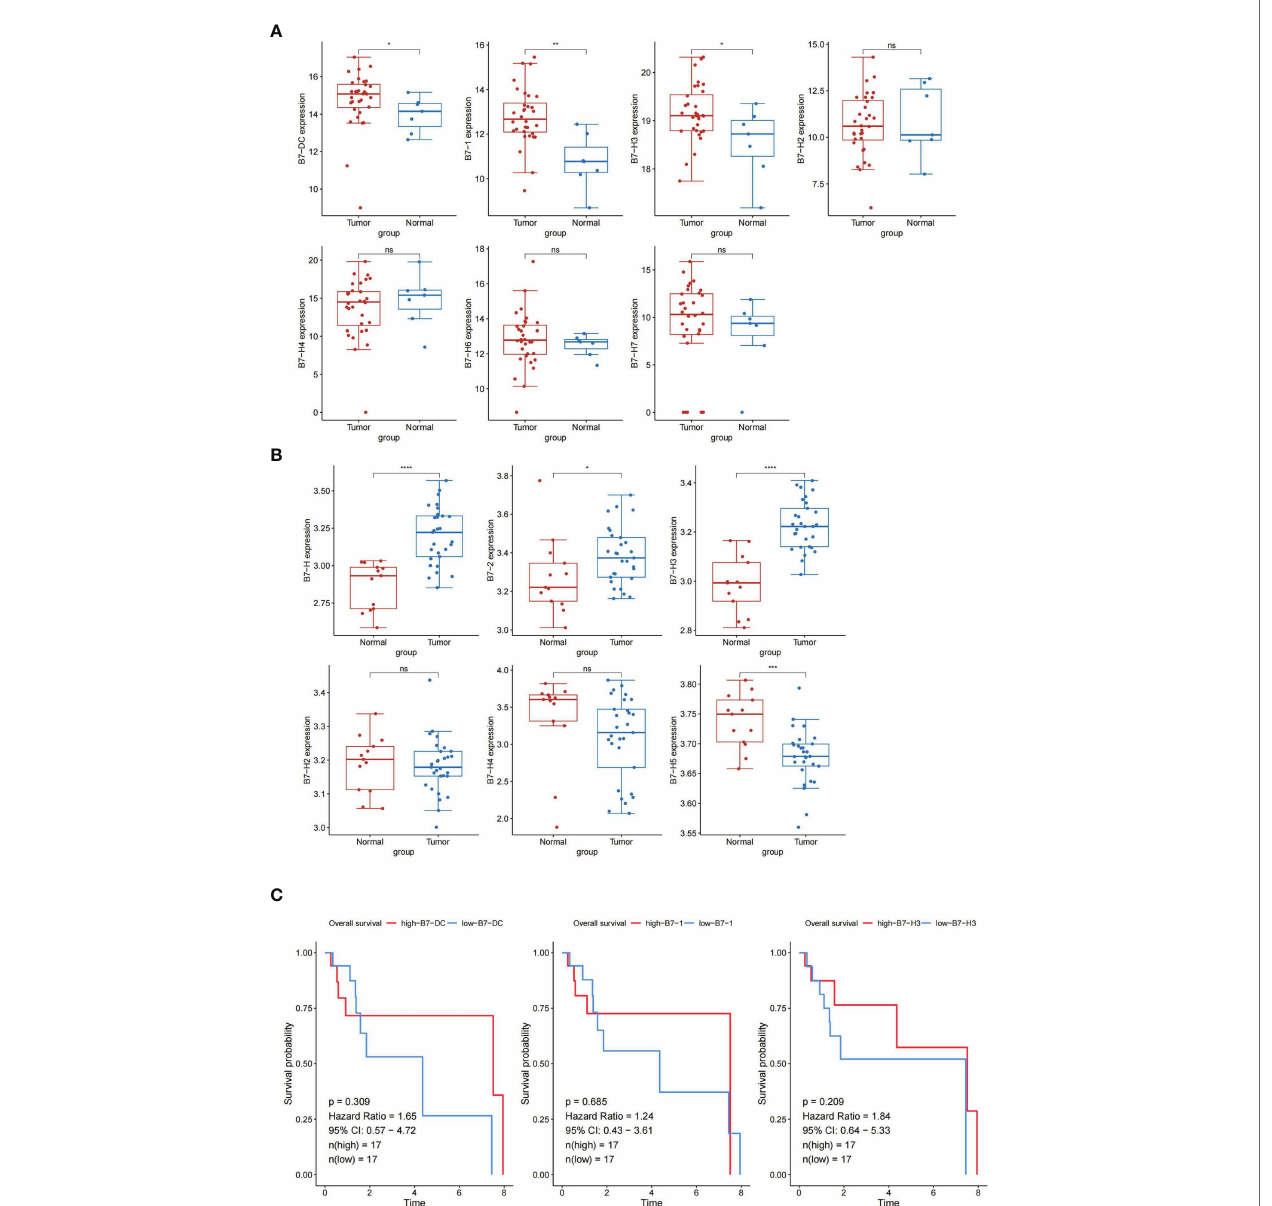
FIGURE 1 | The expression levels of B7 family members in LSCC samples and normal tissues. The data was obtained from TCGA database (A) and GEO database (B) . ns, not signi fi cant, * p < 0.05, ** p < 0.01, *** p < 0.001,**** p < 0.0001. Overall survival of LSCC patients grouped based on B7-1 , B7-DC , and B7-H3 expression level by Kaplan-Meier analysis (C) . p < 0.05 considered as signi fi